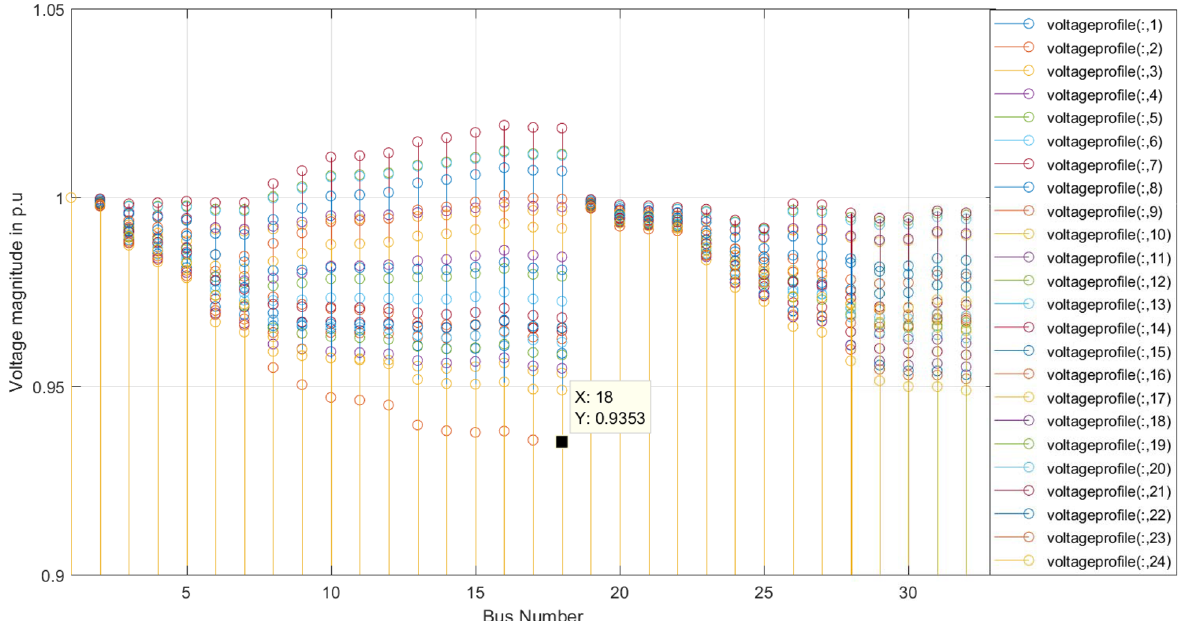
Fig. 6 Voltage profile of the test system after optima placement of DGs at upf by